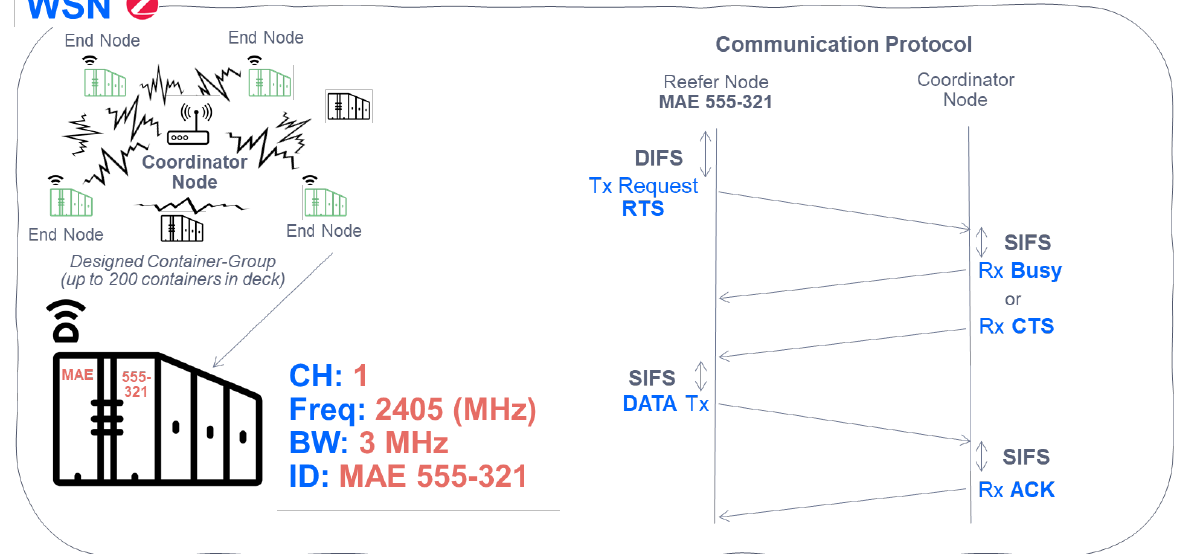
Figure 12. Access to the Medium for data transmission in the WSN Reefer-Coordinator